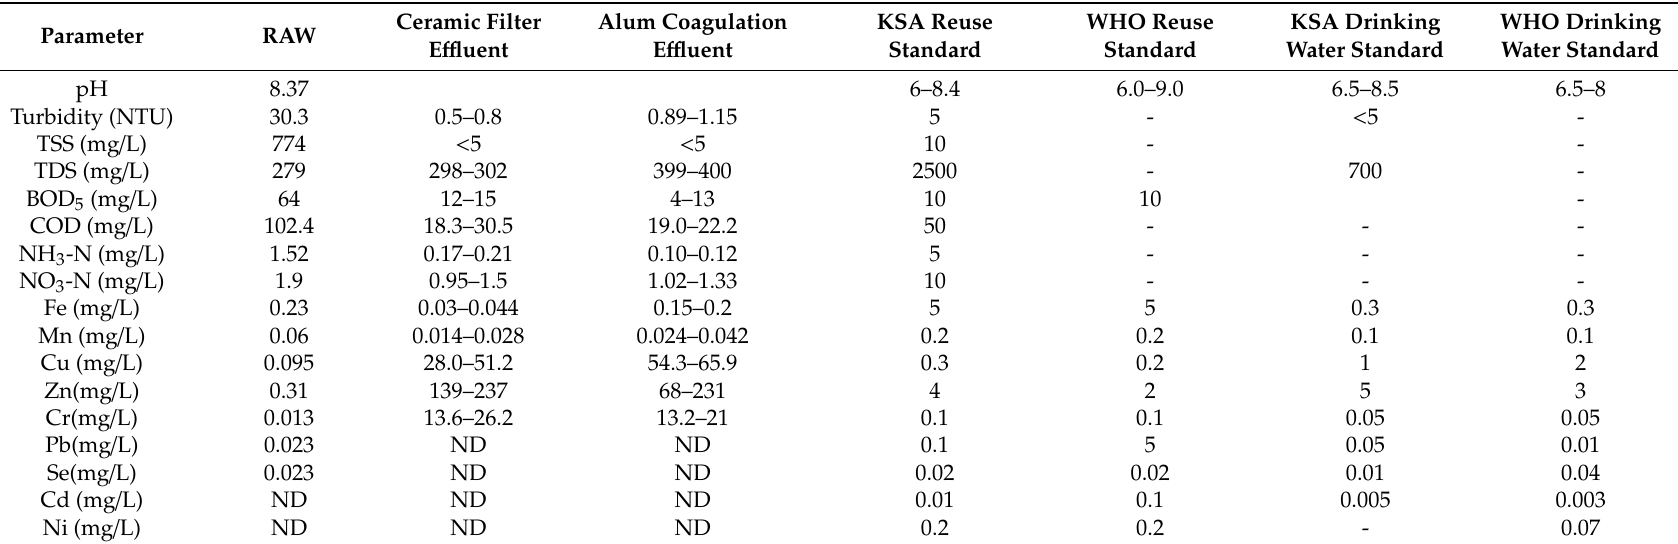
Table 4. Stormwater quality of two processes and standard limits for recycling and drinking